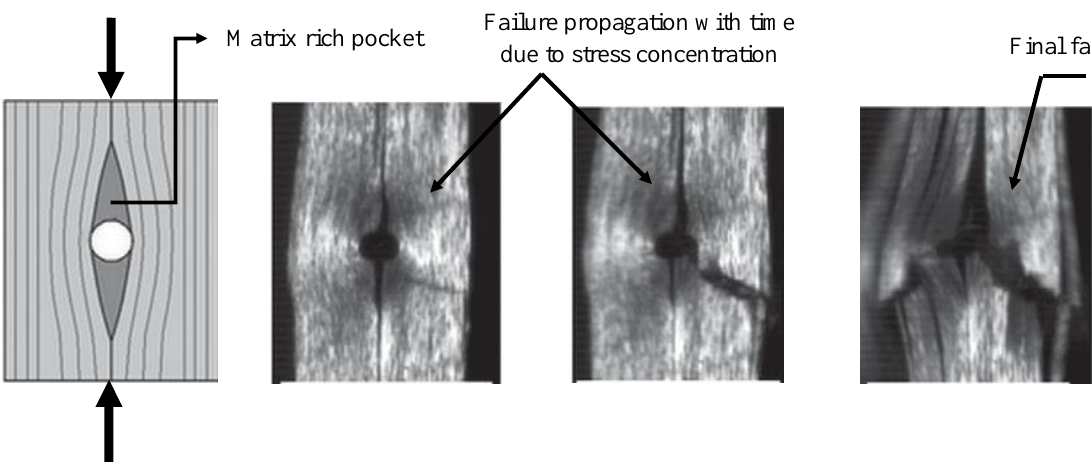
Figure 2: Failure propagation in composite laminated plate (with embedded circular vasculature) due to stress